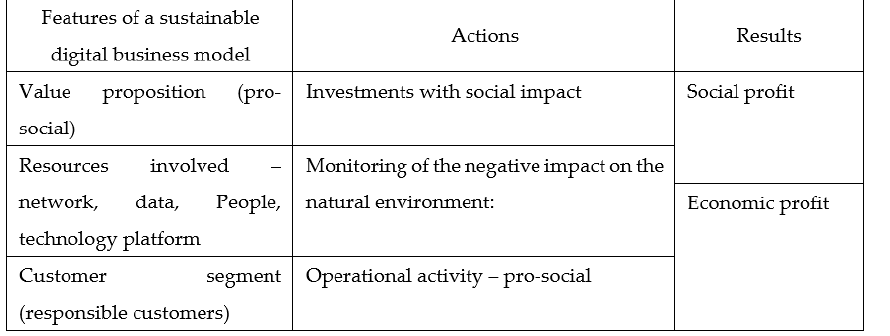
Figure 1. Social Impact—A graphic model defining the factors of Sustainable Digital Business Models including actions focused on creating Social Impact (own study).